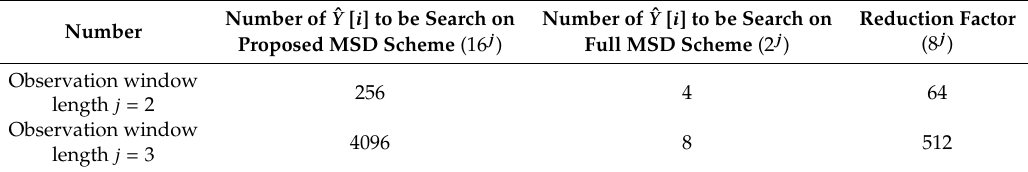
Table 4. Complexity comparison.